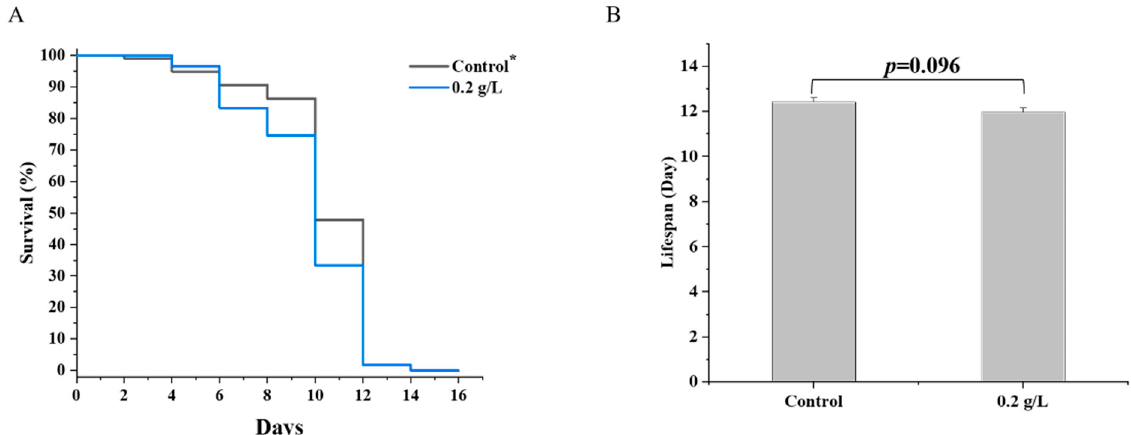
Figure 5. ( A ) Effect of QBLP on the lifespan of mutant worms CF1038 ( daf-16 (mu86) ). ( B ) Mean lifespan results for mutant worms CF1038 ( daf-16 (mu86) ) treated with 0.2 g/L of QBLP. * Control indicates the control group (no additional QBLP was added to the medium).